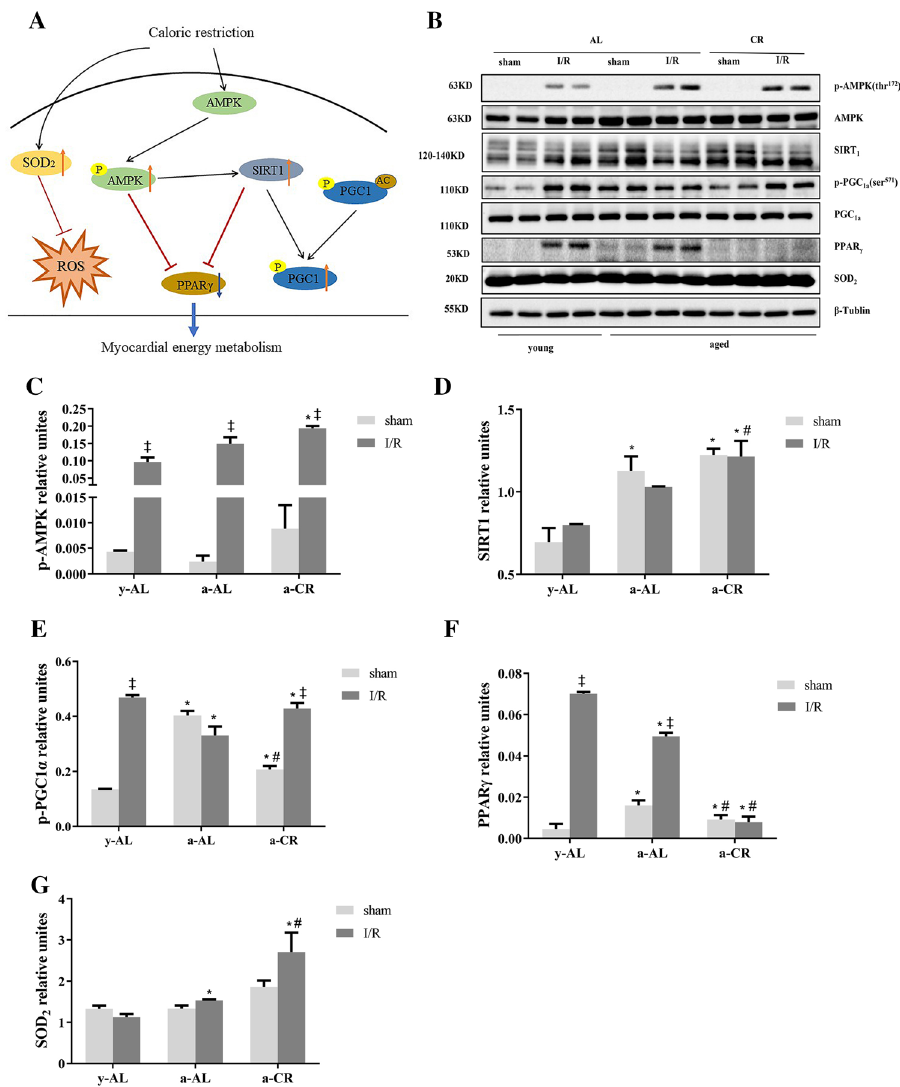
Figure 6. Expression of cardiometabolic proteins. ( A ) AMPK/SIRT 1 /PGC 1a signaling pathway. CR leads to activation of AMPK. AMPK regulates SIRT 1 by inducing NAD + . SIRT 1 activates PGC 1a by phosphorylation and deacetylation. AMPK and SIRT 1 synergistically inhibit PPARγ. CR increases SOD 2 expression in vivo and inhibits ROS. ( B ) Representative images of immunoblotting for p-AMPK, SIRT 1 , p-PGC 1a , PPAR-γ, and SOD 2 . ( C ) Quantitative results of p-AMPK protein. ( D ) Quantitative results of SIRT 1 protein. ( E ) Quantitative results of p-PGC 1a protein. ( F ) Quantitative results of PPAR-γ protein. ( G ) Quantitative results of SOD 2 protein. The westerns were cut prior to incubation with the primary antibodies, the full size blots can be